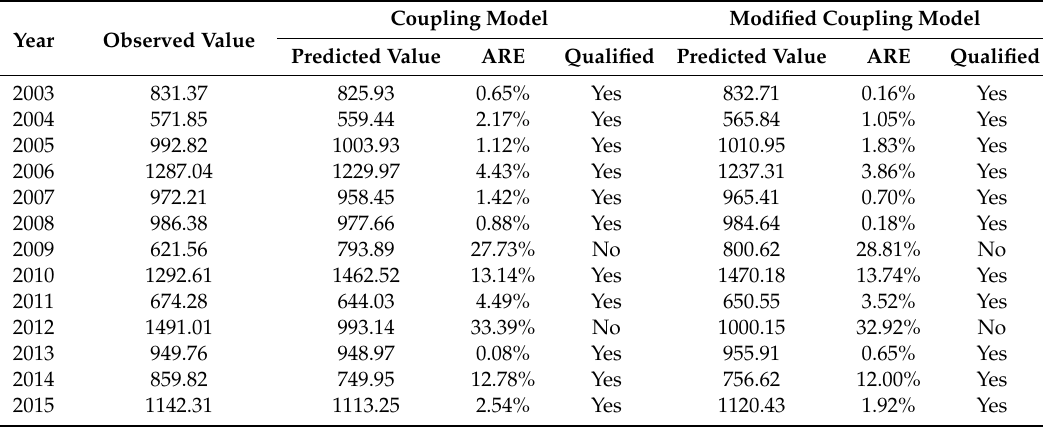
Table 7. Comparisons of annual runo ff sequences predicted by the coupling model and the modified coupling model (note: units of the observed value and the predicted value are m 3 /